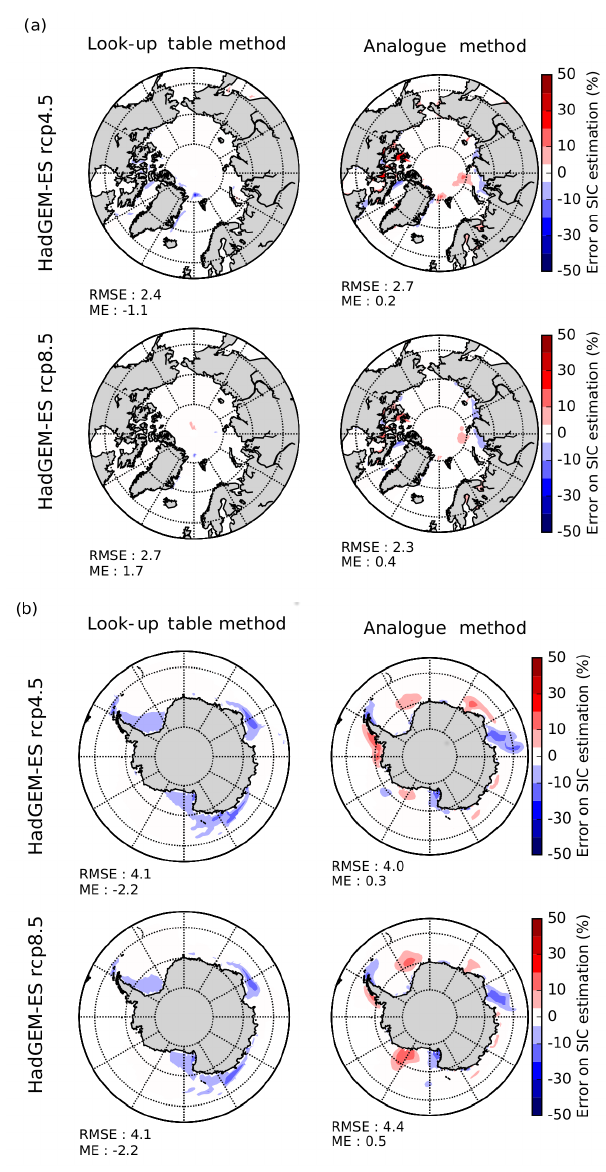
Figure B3. Mean error in the estimation of SIC with respect to the original AOGCM future scenario within the framework of the perfect model test for the LUT and the analogue methods with HadGEM2-ES RCP4.5 and RCP8.5 scenarios for the Arctic (a) and the Antarctic (b)